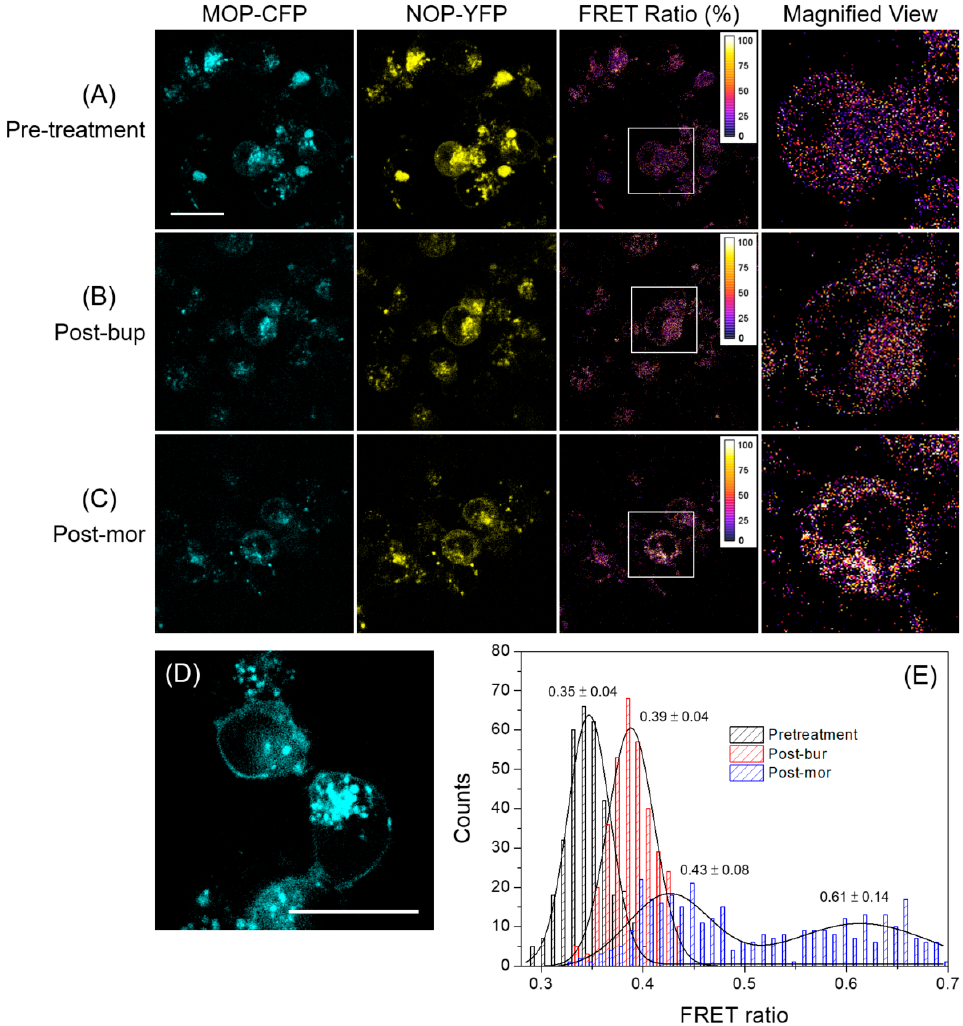
Figure 1. HEK 293 cells transiently transfected with MOP-CFP and NOP-YFP were serum-starved overnight; vehicle (ddH 2 O), morphine (1 μ M), or buprenorphine (1 μ M) was added to cells imme- diately before FRET/SPT measurements. ( A – C ) present the results obtained under the conditions of pre-treatment, post-bup, and post-mor, respectively. The images of MOP-CPF (shown in cyan), NOP-YFP (shown in yellow), FRET ratio (%), and a magnified view from a white box in the respec- tive FRET ratio image are shown for each condition from left to right. ( D ) is the control image taken from the MOP-CFP-channel at the pretreatment condition, which is used to confirm whether the receptors are properly expressed on the cell surface. ( E ) The histograms of the FRET ratio obtained from each condition were fitted to Gaussian distributions, indicating the peak value with a standard deviation. Scale bar = 20 μ m. The bin size of the histogram = 0.01. Twelve cells were used for statis- tical analysis in each condition.